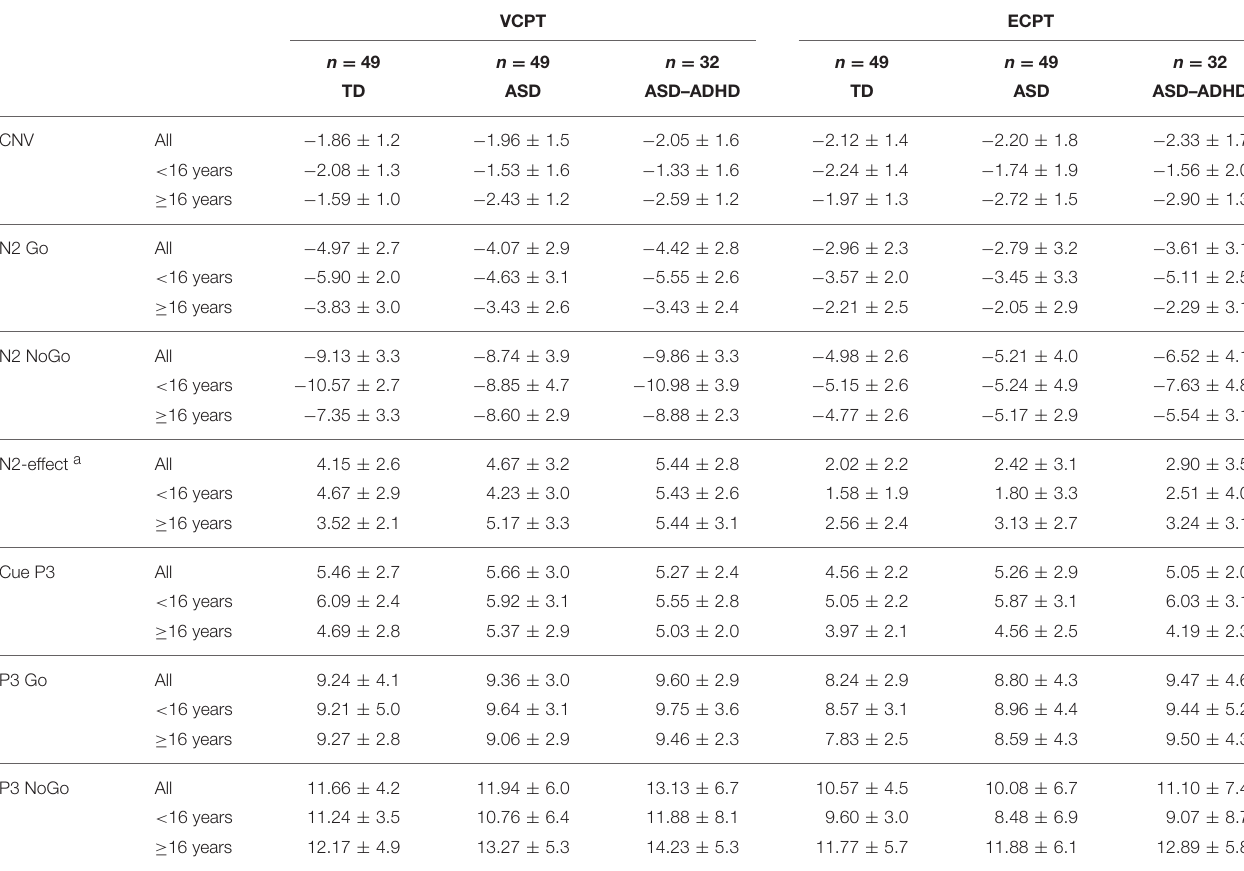
TABLE 3 | Event Related Potentials, ERPs, in VCPT and ECPT, for TD, ASD, and ASD without comorbid ADHD (ASD–ADHD). VCPT ECPT n = 49 n = 49 n = 32 n = 49 n = 49 n = 32 TD ASD ASD–ADHD TD ASD